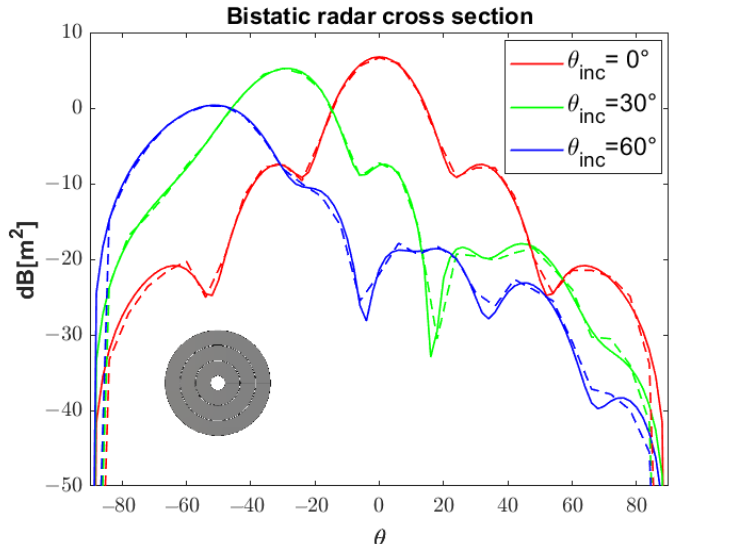
Figure 7. Bistatic radar cross section for geometry #1 (sketched in the inset) for different incidence angles θ inc . Solid line: this method; dashed line: CST Microwave